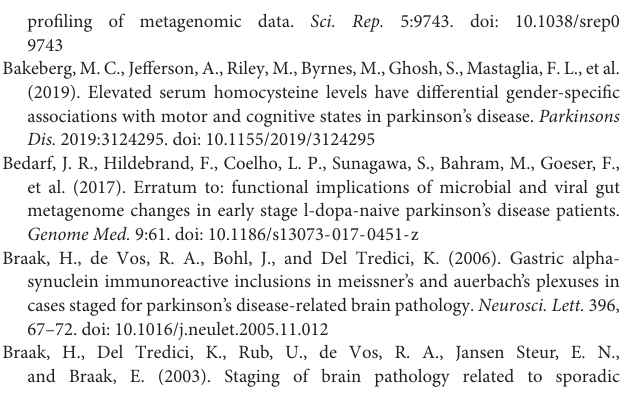
Supplementary Table 1 | Raw sequencing data following V3 V4 16s rRNA analysis. Supplementary Table 2 | Primer sequences for